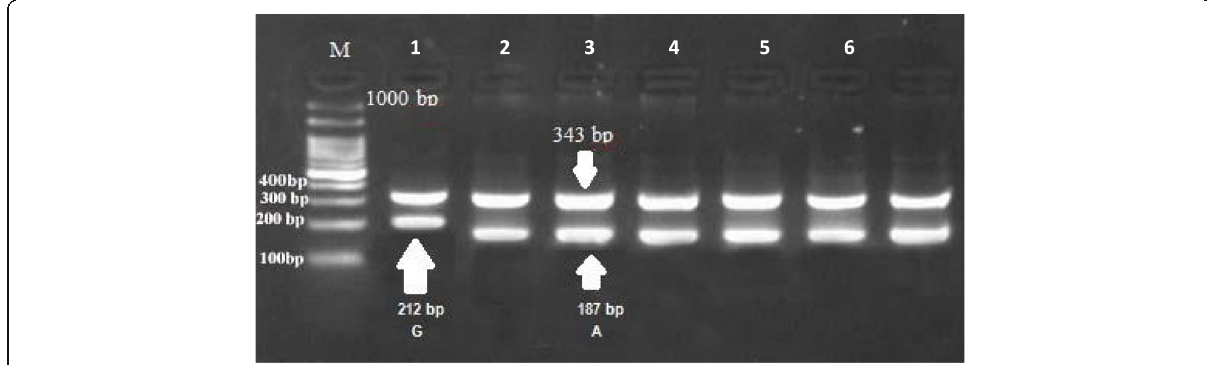
Fig. 4 Electrophoresis of agarose gel (2%) of polymerase chain reaction (PCR) product of tetra primer amplification refractory mutation system- PCR for G7 locus of GDF9 gene. The Lanes of 1 to 7: Amplification of wild type or heterozygous in a mother goat genomic DNA. Sizes of the common outer product (343 bp) and allele-specific wild type (212 bp) and mutant-type (187 bp) inner product are indicated by an arrow of the respective gel photograph. Lane M: DNA molecular weight marker (O` Range Ruler 100 bp DNA Ladder, Fermentas, Lithuania). G = wild type allele, A = mutant